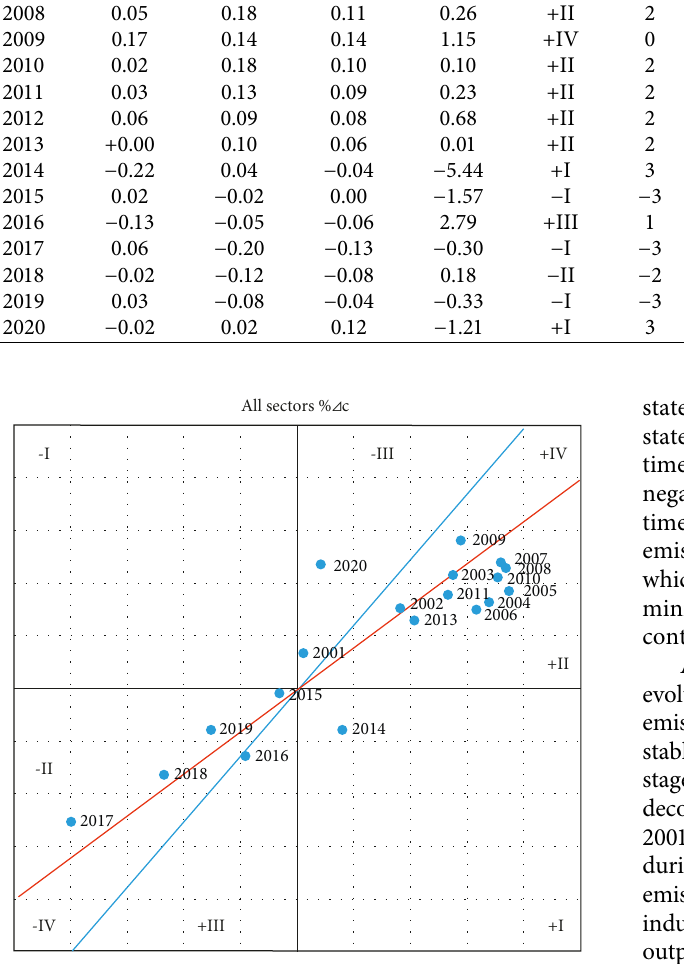
Figure 23: Carbon emission decoupling states of energy con- sumption in mining industry from 2001 to